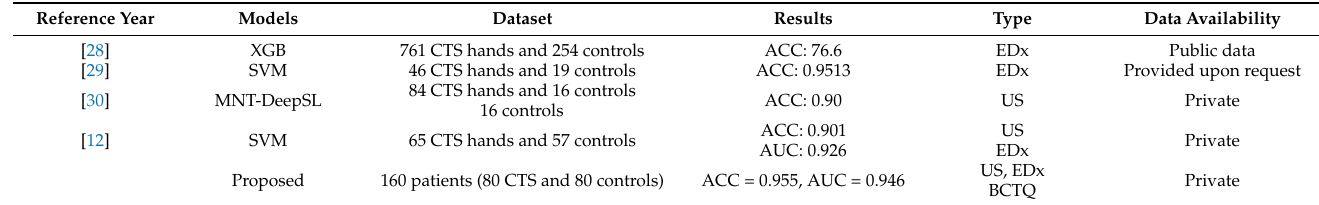
Table 5. Comparison with other work in terms of diagnosis detection.